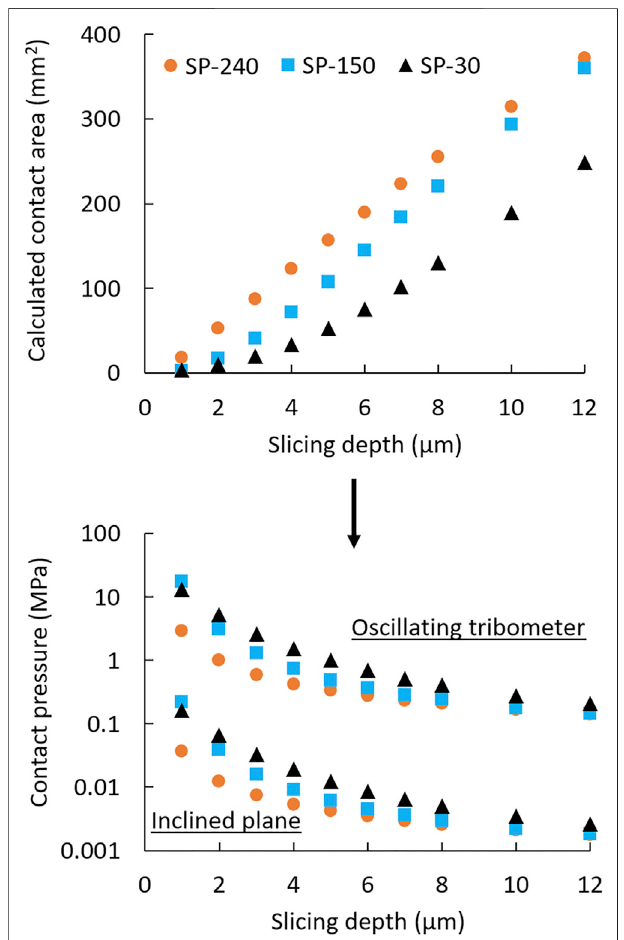
FIGURE9|(A) Calculatedsamplecontactareavaluesatdifferentslicing depths. Due to the curved sample surface, the contact area increases at a higher slicing depth. The smoothest sample (SP240) has the largest contact area and thus the lowest contact pressure. (B) Calculated contact pressure (shown in logarithmic scale) at various slicing depths for both experimental setups. The largest differences in contact pressure between the samples occur at smaller slicing depths, where surface asperities play a larger role. If the sample surface were sliced at 12 µm below the highest surface peak, the contact pressure would be nearly identical for all samples. The